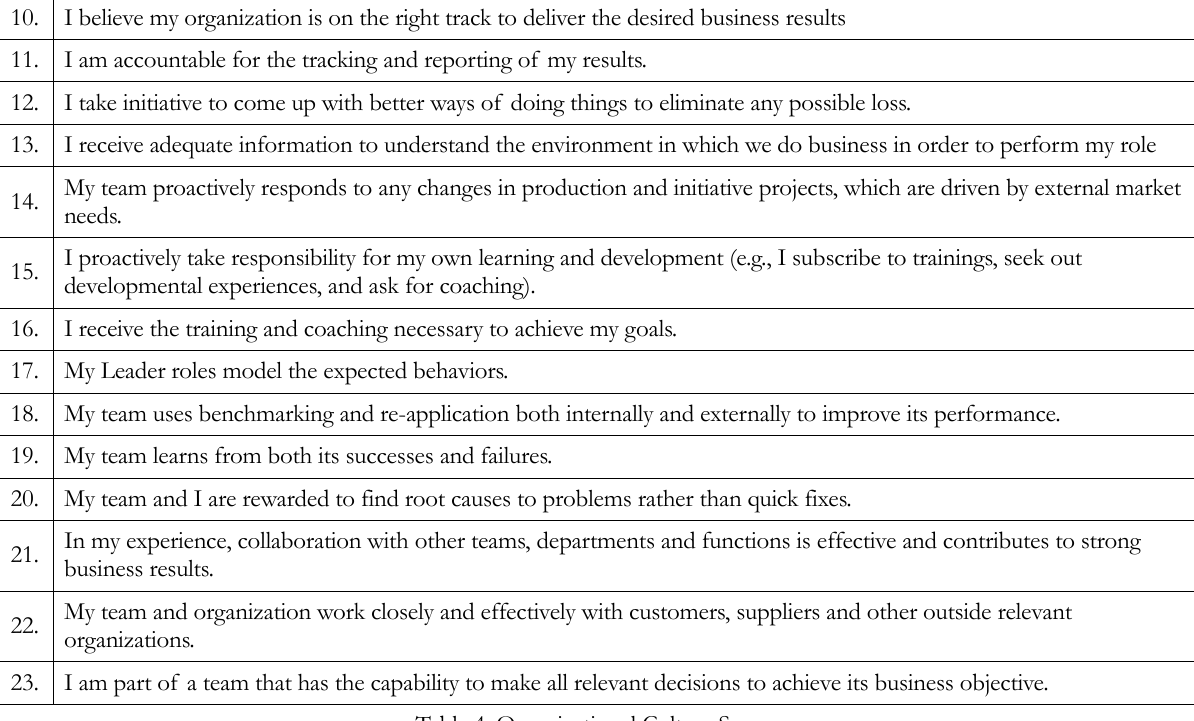
Table 4. Organizational Culture